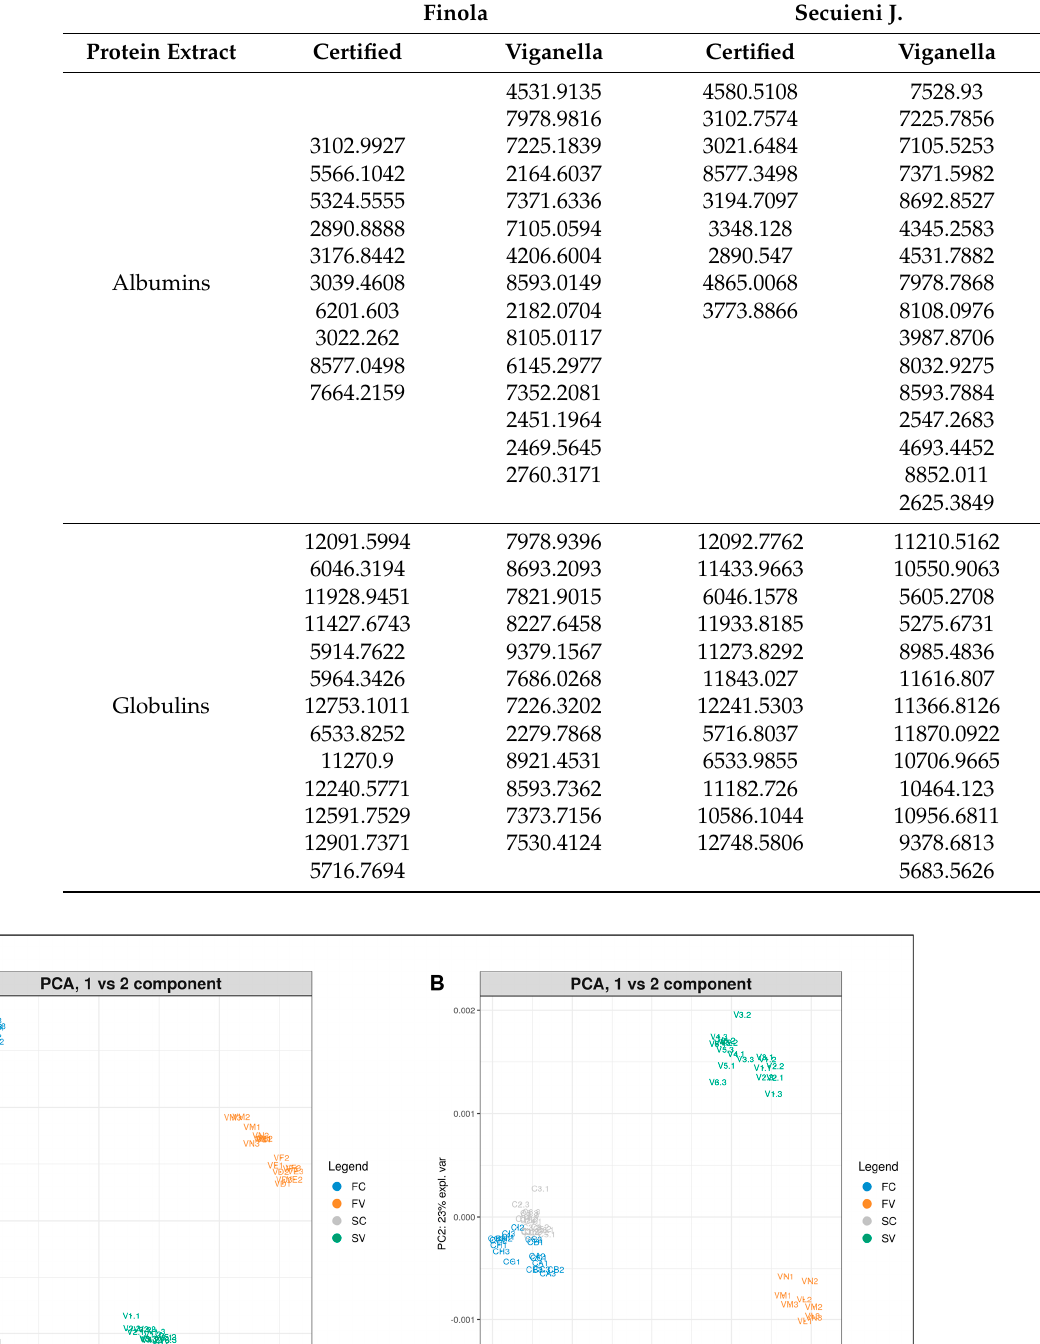
Table 5. Mass signals from albumin and globulin extracts of Finola and Secuieni J. seeds correspond- ing to the top 25 loadings on PC1 and their correlation with seed origin (certified vs. Viganella).